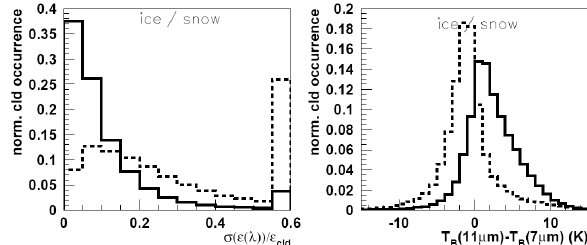
Figure 3. Same distributions as in lower panels of Fig. 2, but this time for observations at 13:30 LT.